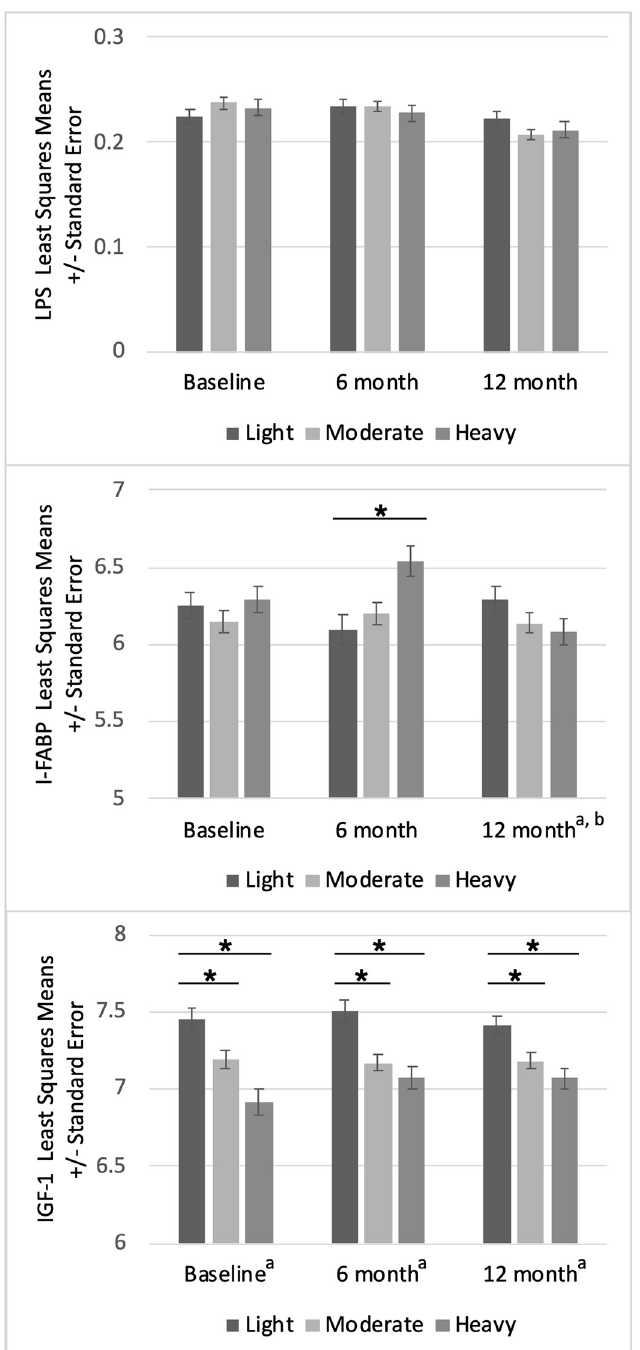
Fig 1. Biomarkers by baseline S . mansoni intensity. Least squares means and standard errors for lipopolysaccharide (LPS, EU/mL), intestinal fatty acid binding protein (I-FABP, pg/mL), and insulin-like growth factor 1 (IGF-1, pg/mL) concentrations at each visit (baseline, 6-months, and 12-months) by baseline S . mansoni intensity category. Asterisks represent significant differences determined by multivariate regression with light infection intensity as the reference category. Stepwise selection retained variables of a) age and b) WAZ. Continuous variables were natural log- transformed.